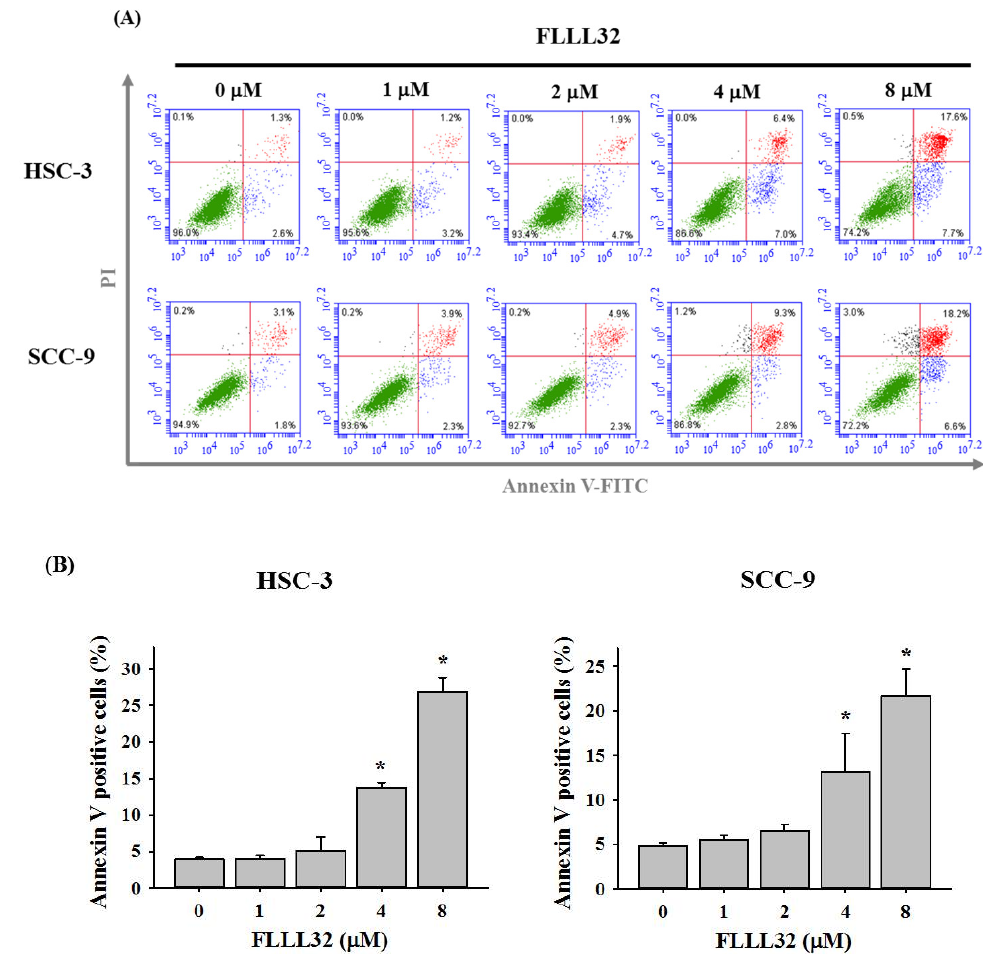
Figure 3. FLLL32 induces cell apoptosis in oral cancer cells. ( A ) HSC-3 and SCC-9 cells were treated with 0, 1, 2, 4, or 8 μ M FLLL32 for 24 h and subjected to flow cytometry after annexin V–FITC/PI staining. ( B ) The quantitative percentage of apoptotic cells, including early apoptotic and late apoptotic cells, was increased by FLLL32 in HSC-3 and SCC-9 cells in a dose-dependent manner. Data are presented as the mean ± SD, and all experiments were independently repeated at least three times; * p < 0.05 compared with the vehicle